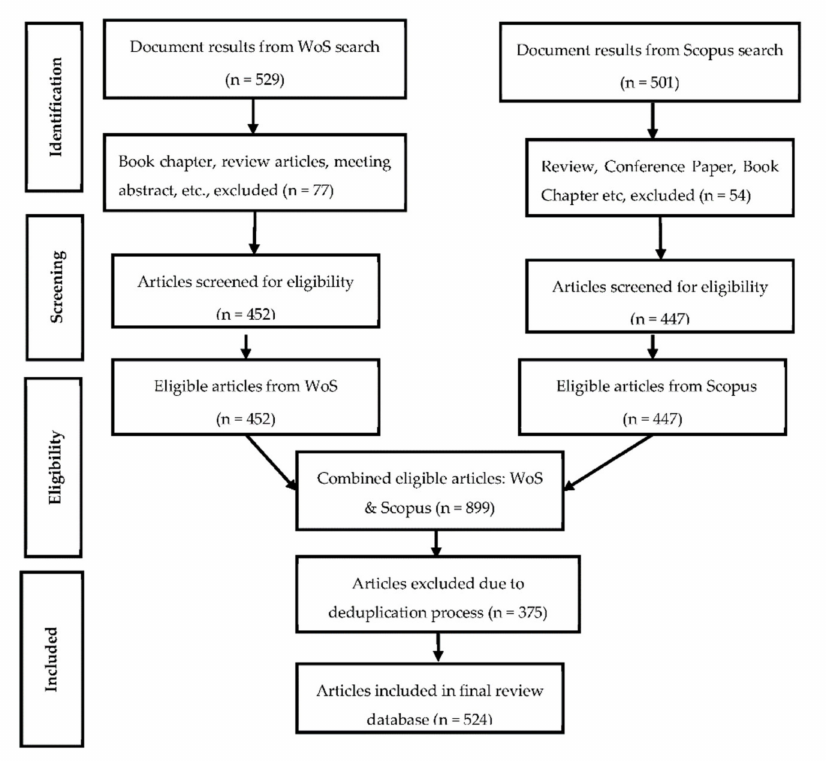
Figure 1. The PRISMA (preferred reporting items for systematic reviews and meta-analysis) flowchart of the bibliometric mapping of research related to Arcobacter and its public health implications from the perspective of food–environment